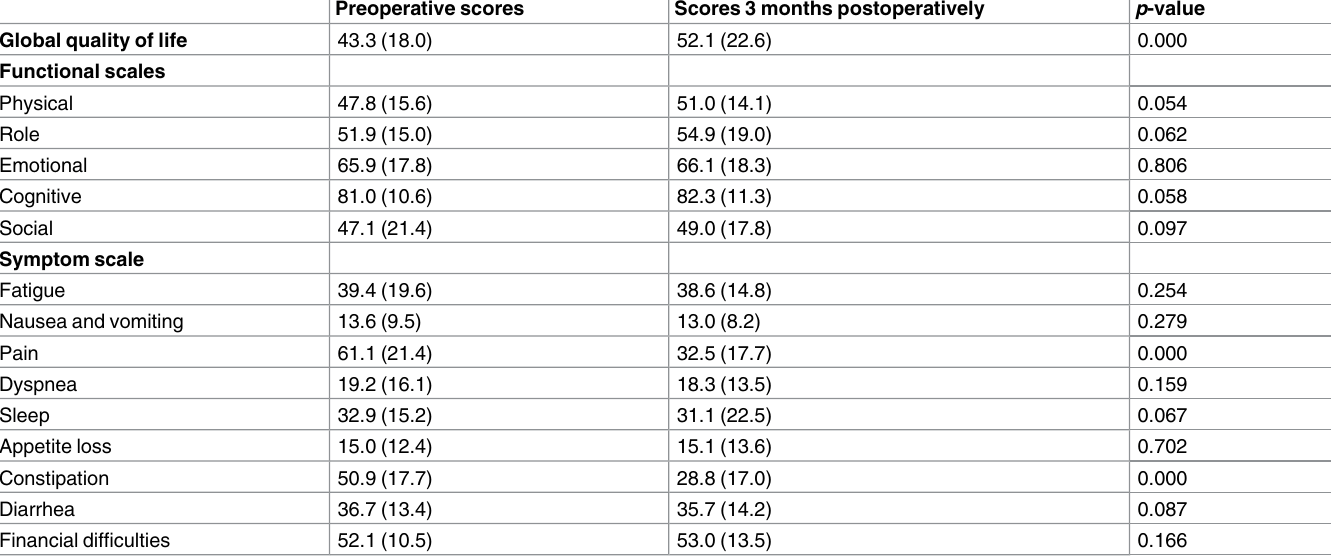
Table 4. Quality of Life Evaluated by QLQ-C30 Before and After Surgical Treatment (mean, SD).